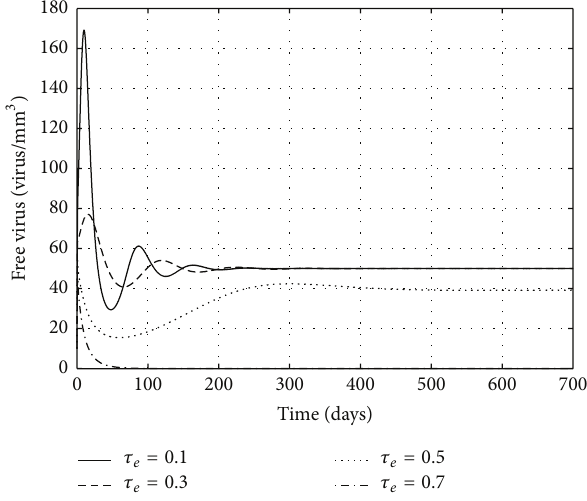
Figure 14: The concentration of free virus particles for model (104).